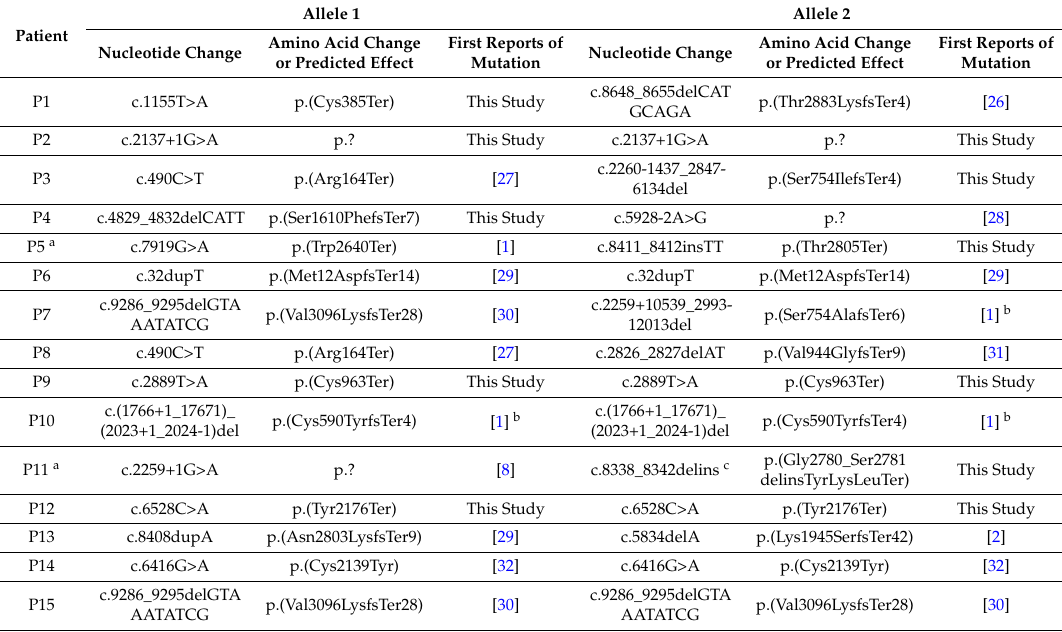
Table 1. Molecular Genetic Results for EYS -retinitis pigmentosa (RP) Patients.